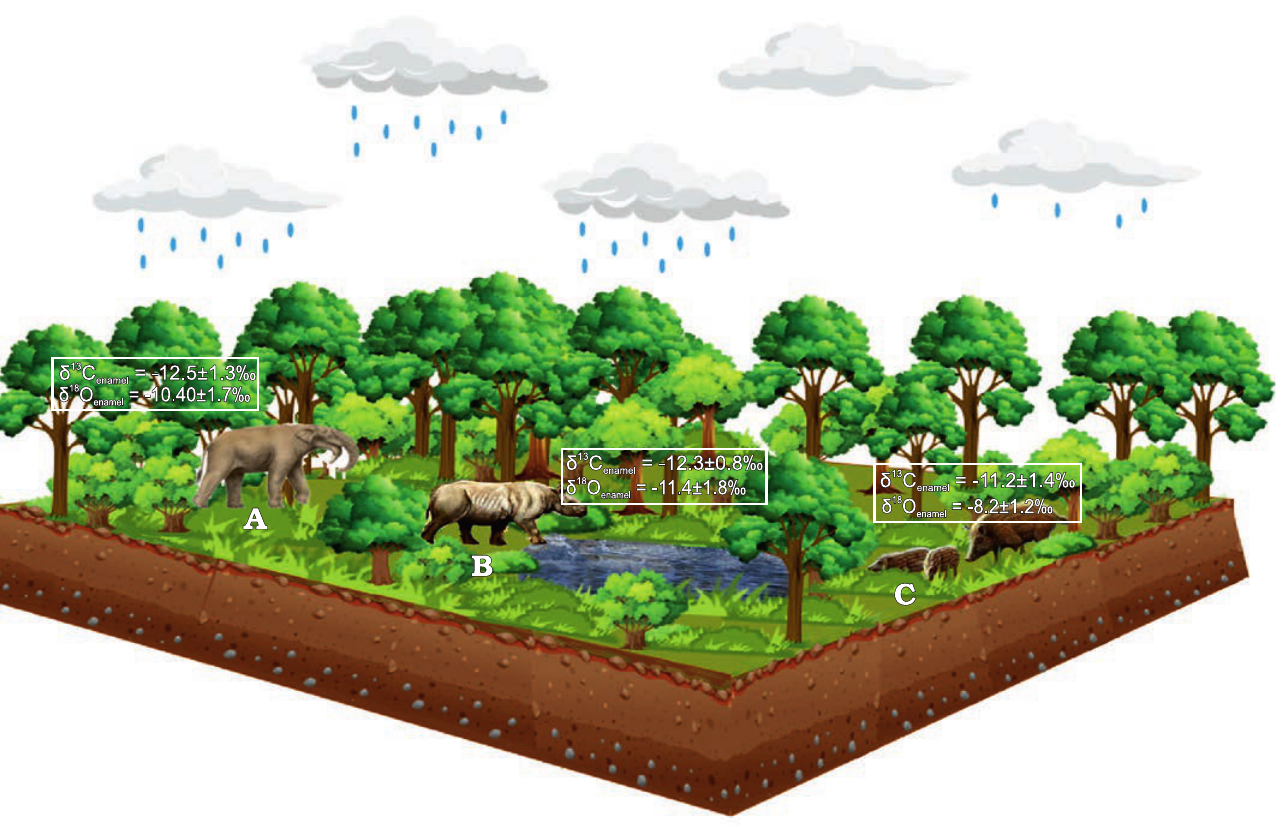
Fig. 3. Reconstruction of the middle Miocene ecology of the Siwaliks and relative habitat partitioning among three mammalian families based on the stable isotope data of carbon and oxygen. Deinotheres ( A ), rhinocerotids ( B ), and suids ( C